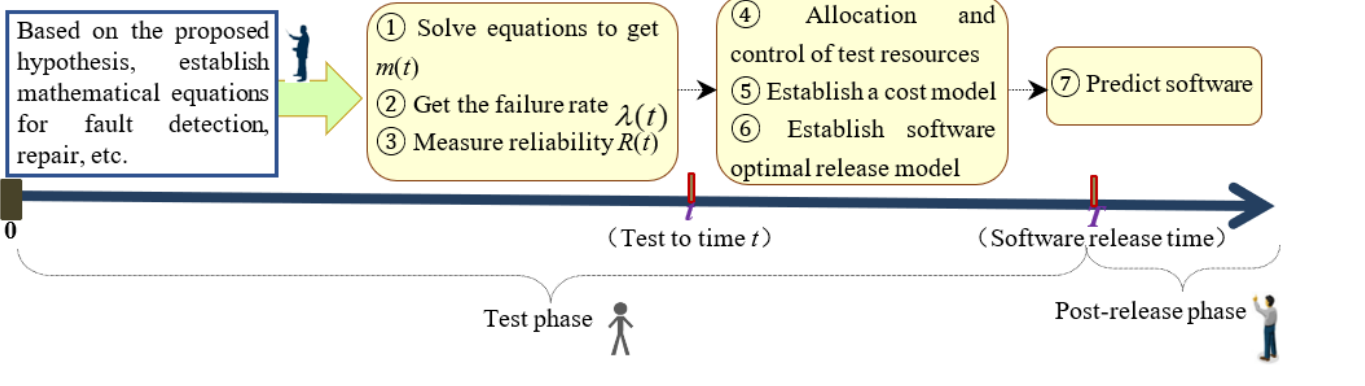
Figure 1. Research Ideas and Functions of SRGM.